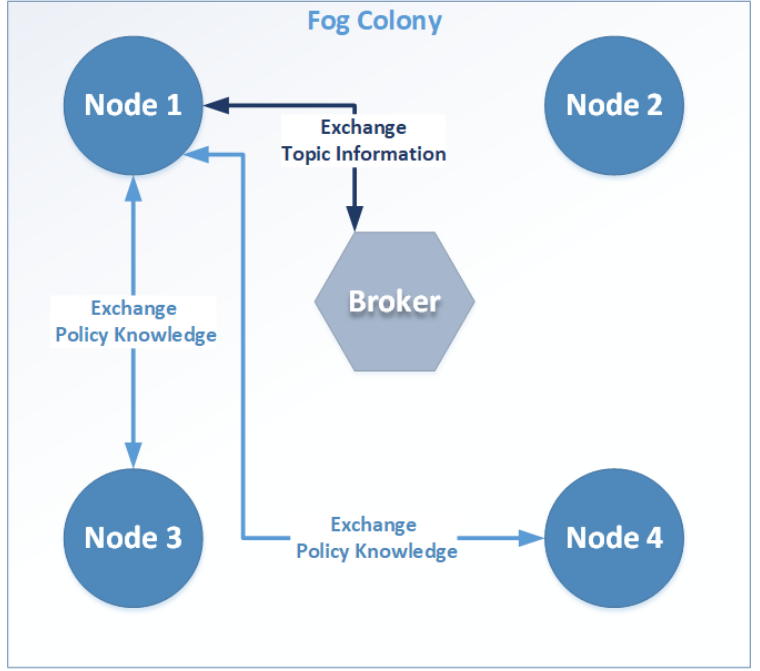
Figure 5. Example communications using a broker and ECTORAS